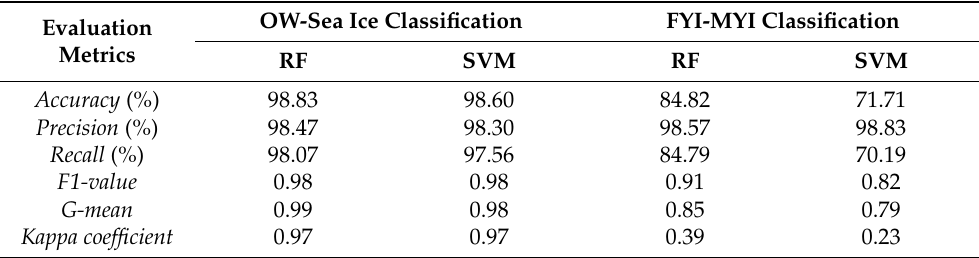
Table 4. The evaluation metrics of open water (OW)-sea ice and first-year ice (FYI)-multi-year ice (MYI)